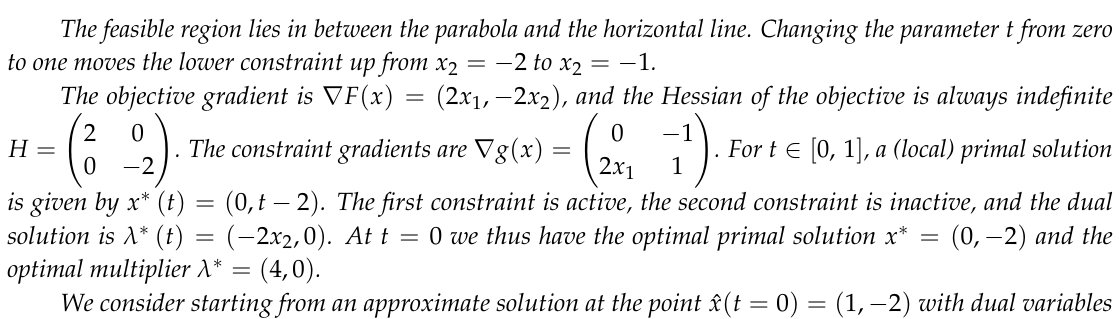
Figure 1. ( a ) Constraints of NLP (16) in Example 1 and ( b ) their linearization at ˆ x = ( 1, The feasible region lies in between the parabola and the horizontal line. Changing the parameter t from zero to one moves the lower constraint up from x 2 =